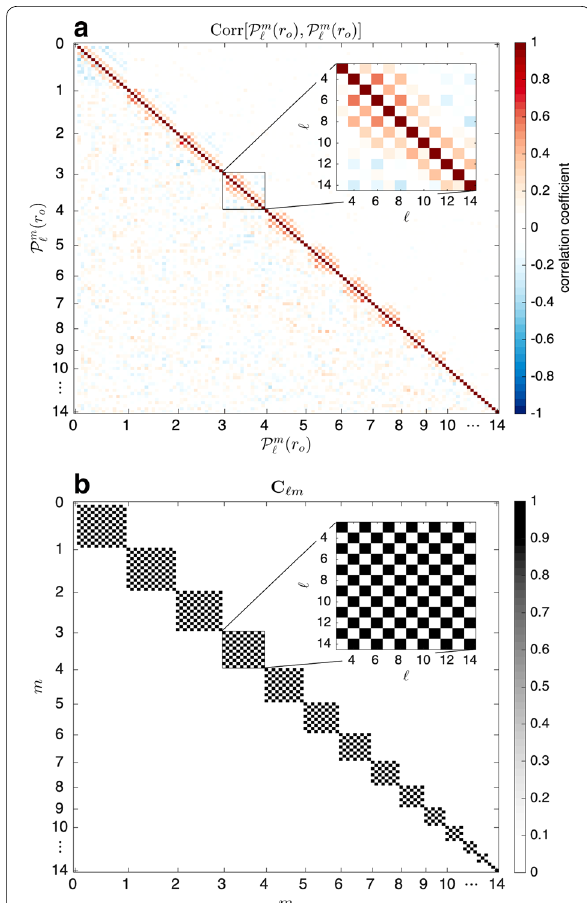
Fig. 1 a Subset of the normalized model covariance P f 0 , corresponding to correlations of the poloidal magnetic field potential at the core surface P m ℓ ( r o ) calculated from the ensemble of dynamo simulations. Note that for illustration purposes the matrix is a composite of two correlation matrices based on ensembles of different sizes: the upper half is calculated using N e = 512 and the lower half with N e = 64 . b The associated localization matrix C ℓ m . The matrices are organized by the stacking of the spherical harmonic degrees ℓ within the corresponding order m , truncated at ℓ = 14 , and the upper insets magnify the region where m = m ′ =